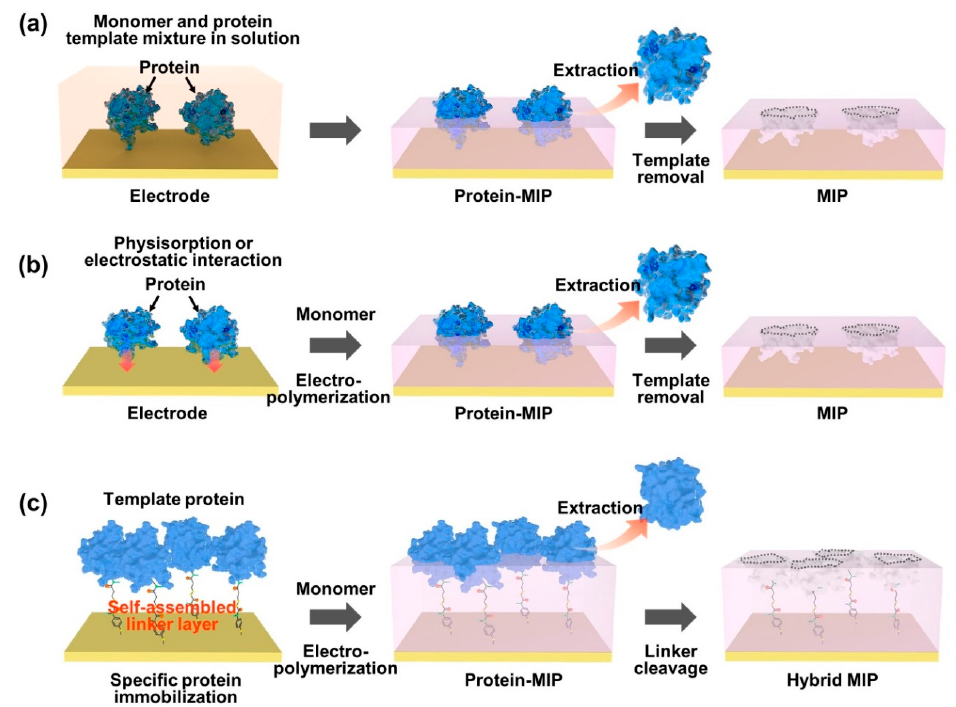
Figure 2. Representative strategies on the surface imprinting process to construct specific protein recognition cavities. In an appropriate design concept, the selective rebinding site can be generated by using a functional monomer for electropolymerization on a prepared electrode surface, which includes the formation of the pre-polymerization complex ( a ), the template physisorption ( b ) and the immobilization of the target protein ( c